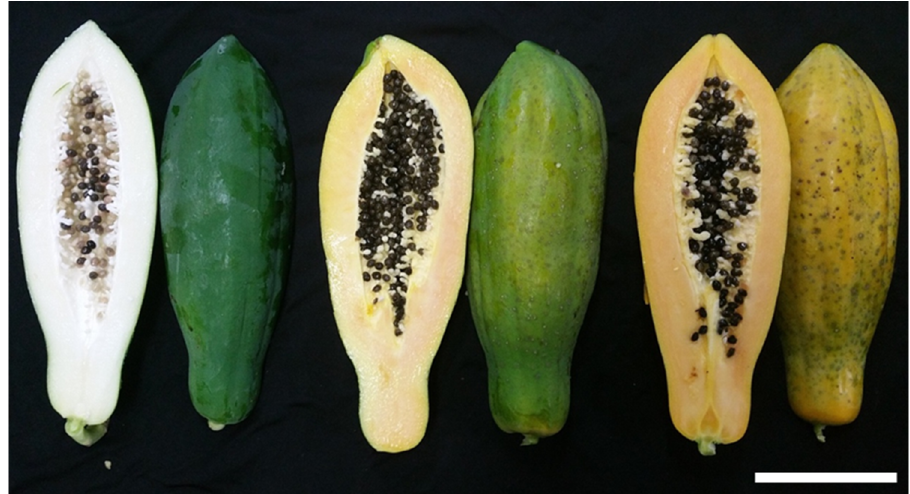
Figure 1. Inner and outer flesh of papaya ( Carica papaya ) fruit across different ripening stages: unripe ( left ), half-ripe ( middle ), full-ripe ( right ). Bar = 10 mm. Table 2. Peel chromaticity of “Tainung No. 2” Red papaya ( Carica papaya ) at 3 parts across ripening stages: unripe at 16 weeks after anthesis (WAA), half-ripe at 18 WAA, and full-ripe at 20 WAA.